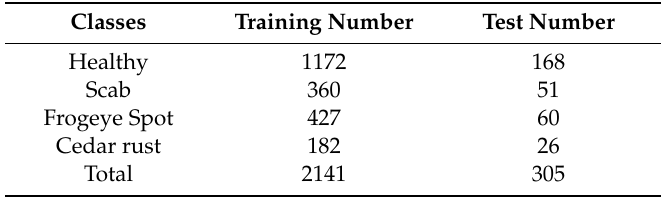
Table 1. Details of the apple leaves.